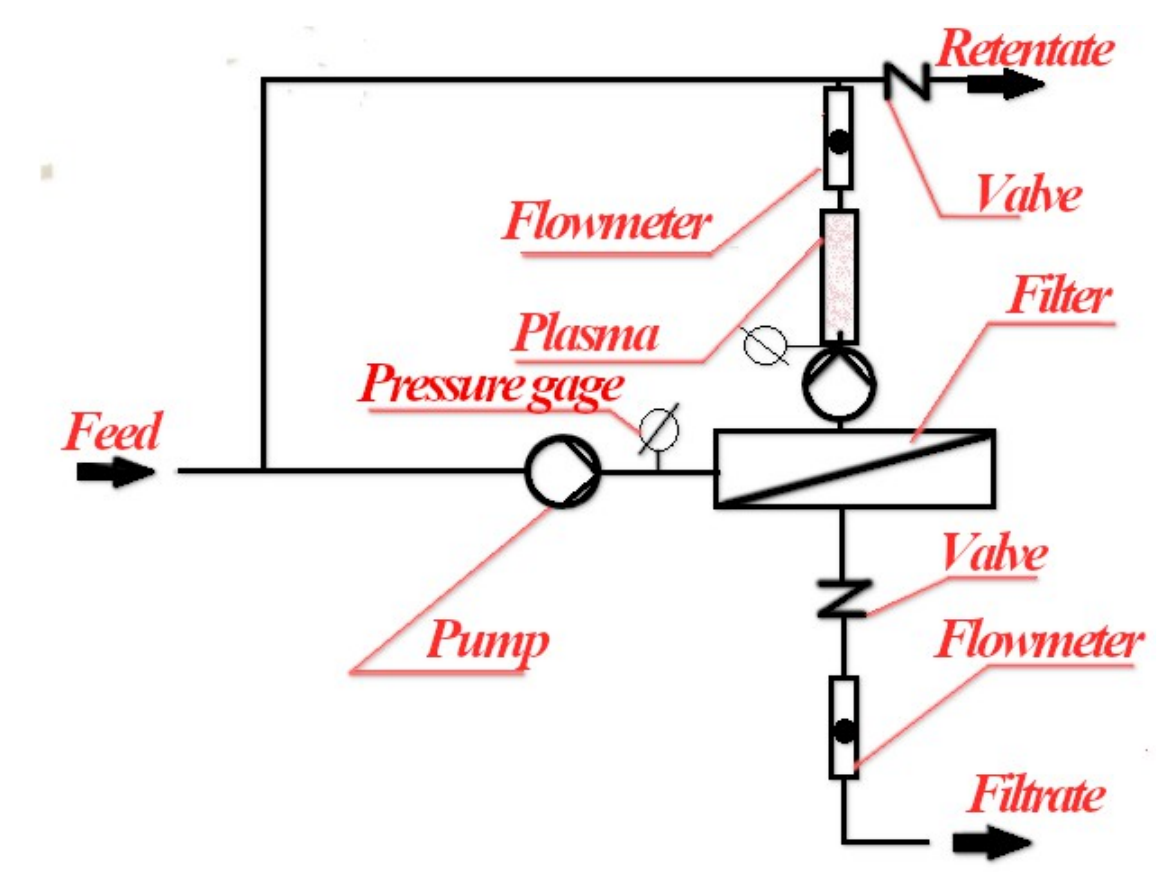
Figure 7. A possible scheme for using “sonoplasmic” discharge in combination with reverse osmosis.